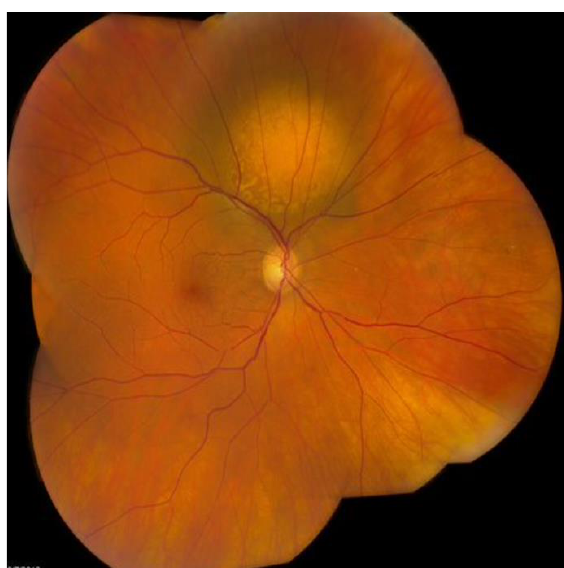
Figure 11. Choroidal metastasis.